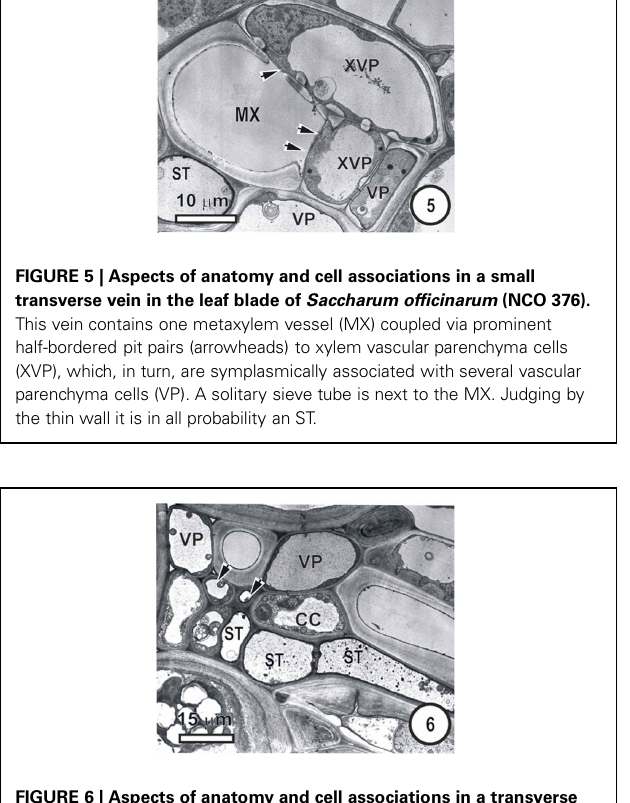
FIGURE 4 | Detail showing a field containing several thin-walled sieve tubes, associated vascular parenchyma (VP) and companion cells (CC). Thin-walled sieve tubes (ST) are connected to CC by pore-plasmodesmata units (PPU).